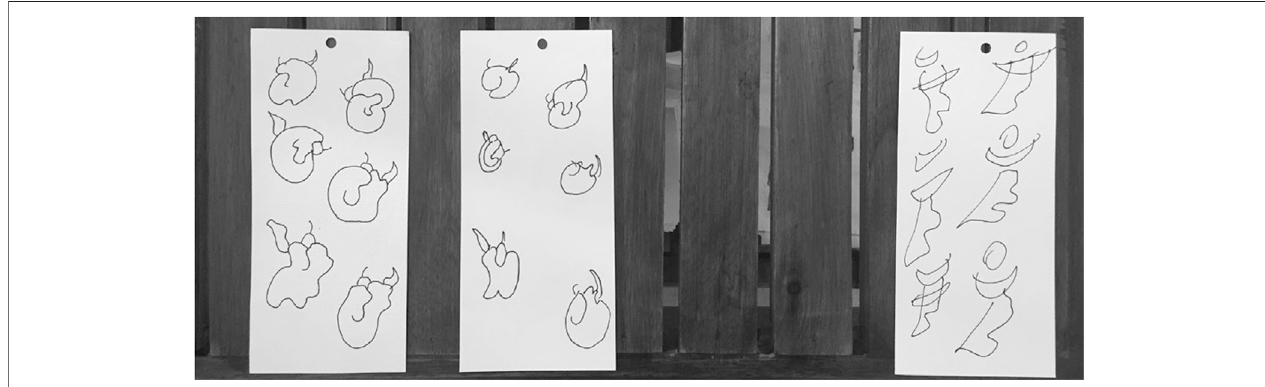
FIGURE 1 | A drawing activity used to illustrate the concept of accumulated mutations. Students saw images on a card (far left) and recreated them. Over 100 students participated, but after only 30 students had recreated the images (far right) , the images were already drastically different.